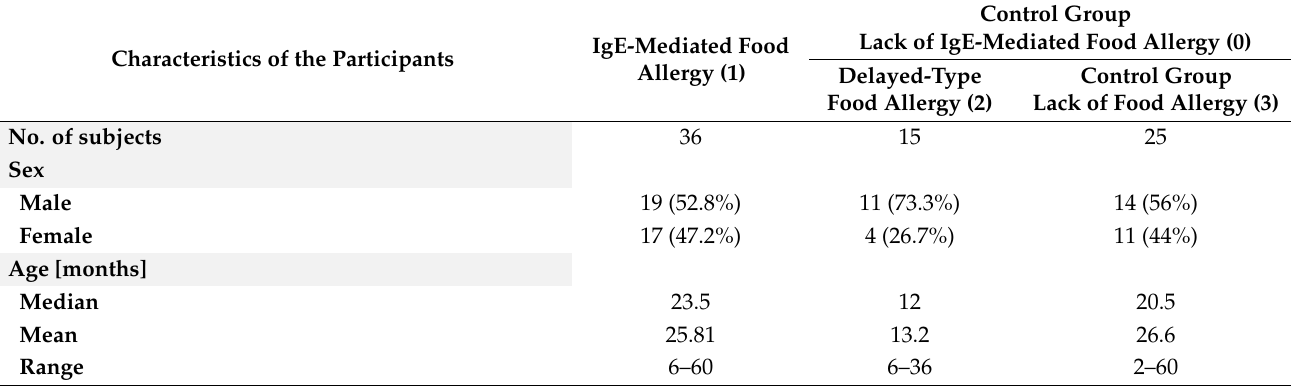
Table 1. Characteristics of